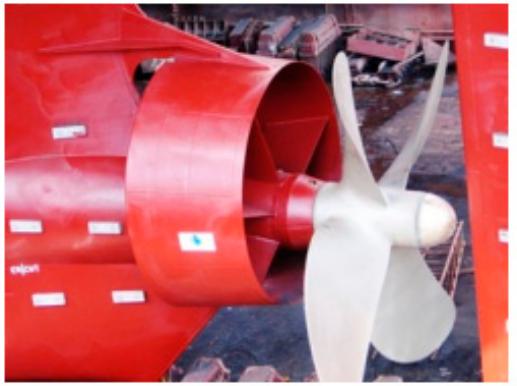
Figure 4. First installed full-scale Mewis Duct ® , STARISTIND, 54,000 tdw MPC